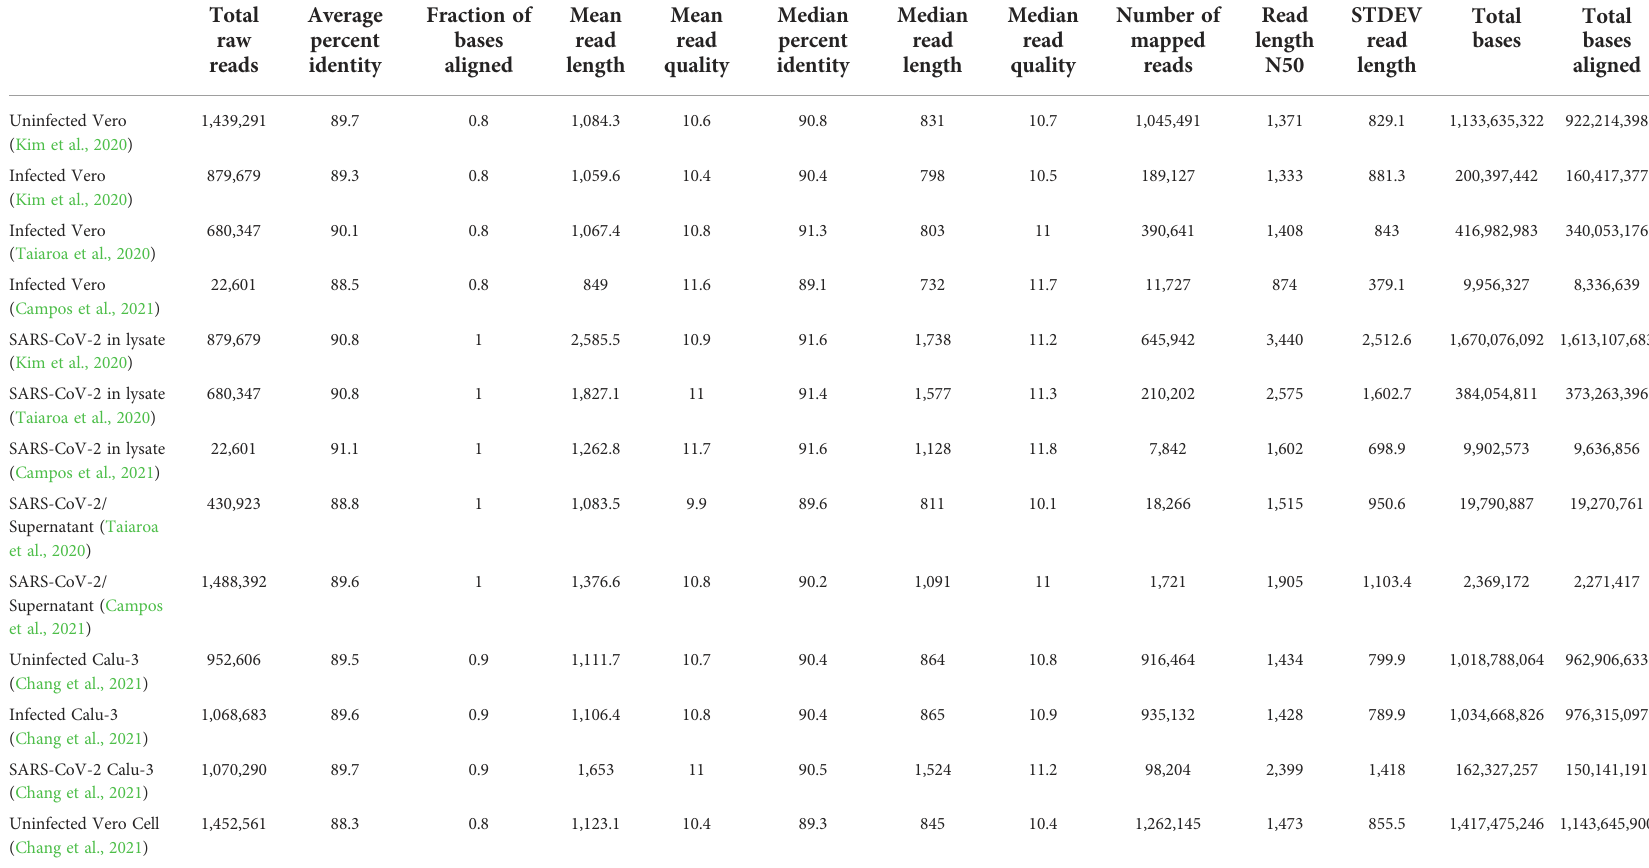
All data are from Vero cells samples except for the three rows indicating samples from Calu-3